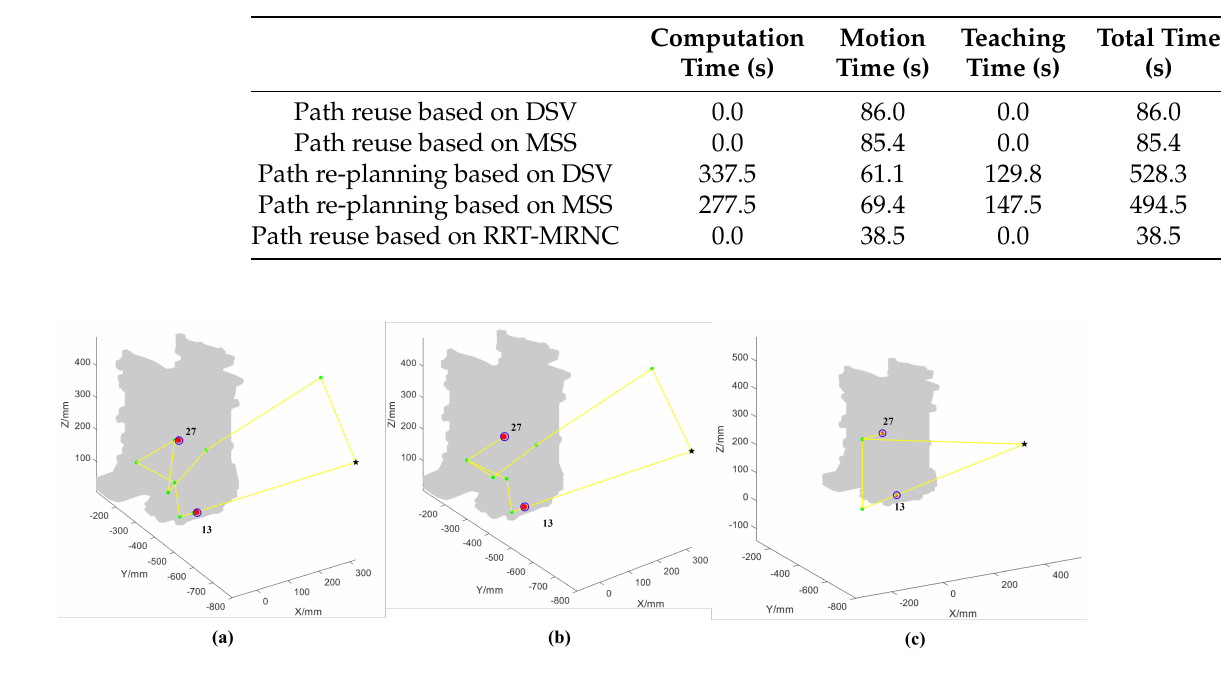
Figure 16. Schematic diagram of reuse path by different methods. ( a ) Reused path diagram based on